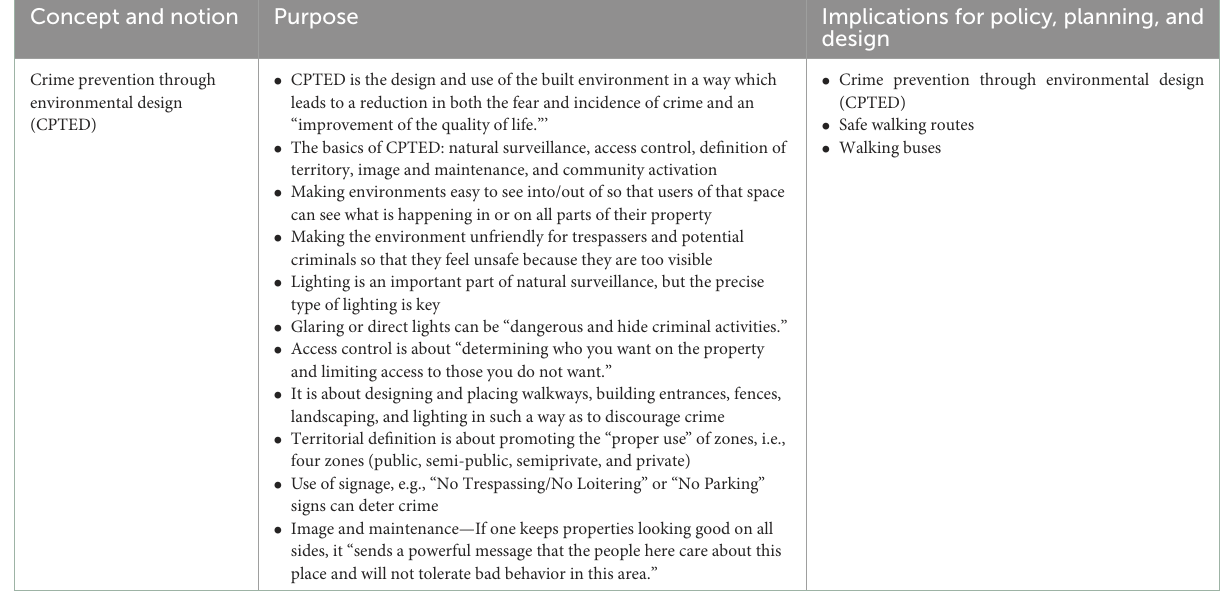
Figure 1): built and neighborhood environments that are easy